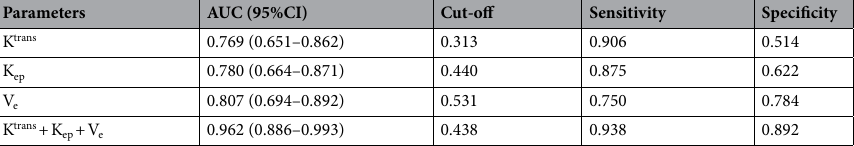
Table 3. ROC analyses of DCE-MRI quantitative parameters. K trans represents all K trans -related features that showed significant differences in univariate analysis (i.e., mean, median, P95, contrast, and entropy). K ep represents all K ep -related features that showed significant differences in univariate analyses (i.e., mean, median, entropy, and diff-entropy). V e represents all V e -related features that showed significant differences in univariate analyses (i.e., mean, median, P95, entropy, and